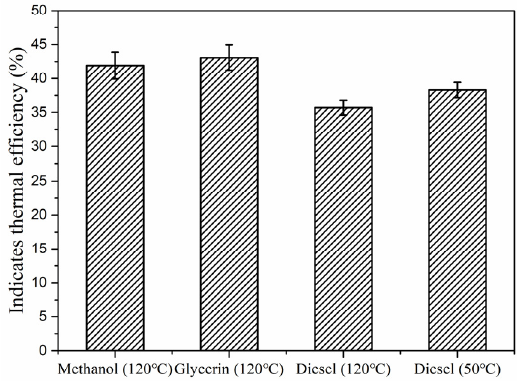
Figure 8. Indicated thermal efficiencies for different fuels. Figure 9 is a comparison diagram of pollutant content in diesel engine exhaust.